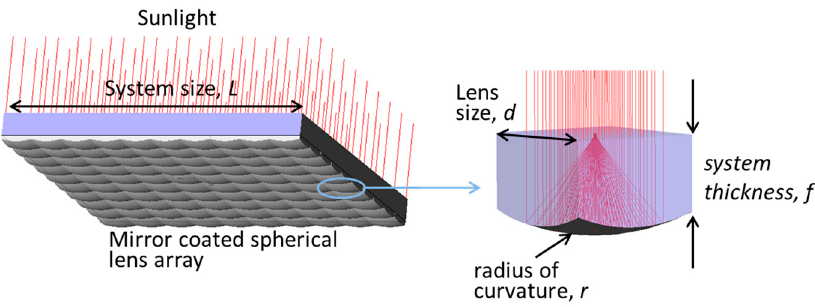
Figure 3. A mirror-coated spherical lens array and its associated parameter and Ray-tracing analysis of a singlet lens.